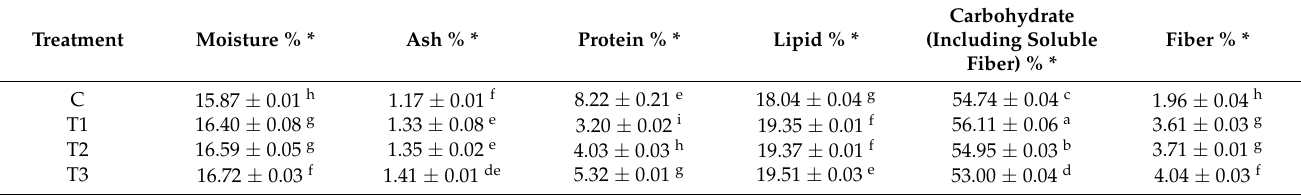
Table 5. The percentage of moisture, ash, protein, lipid, carbohydrate (including soluble fibers) and insoluble fibers of the control sample and the